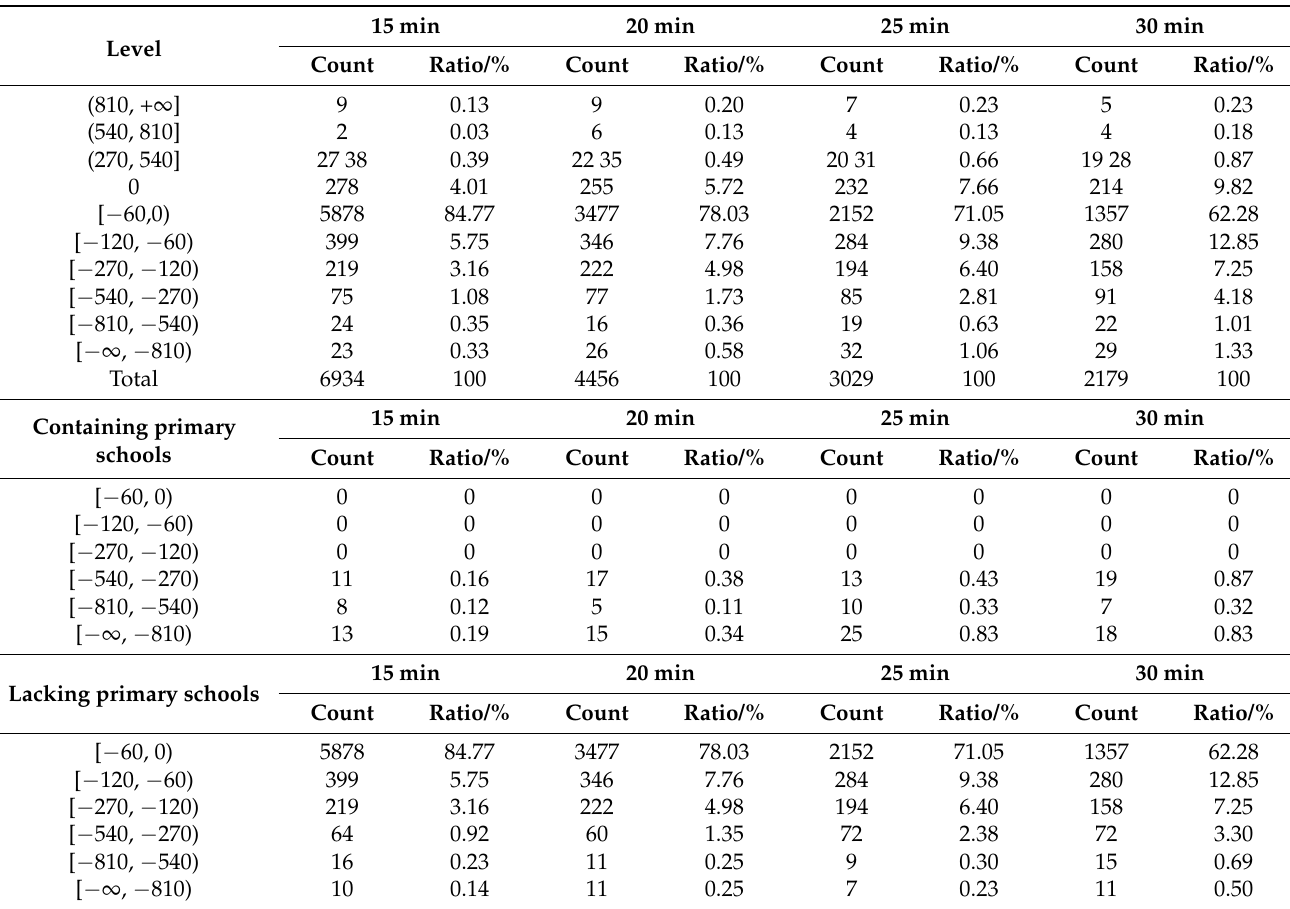
Table 3. Primary educational equilibrium services within the four living circle